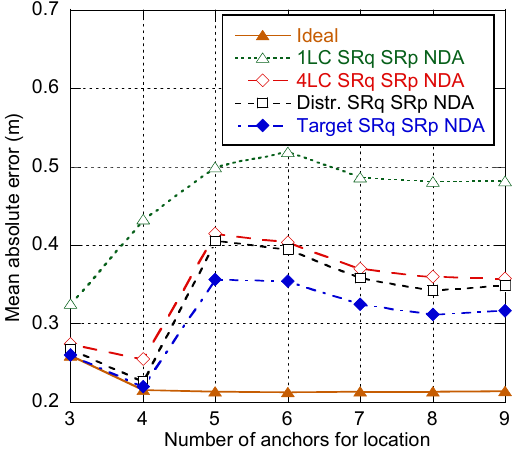
Figure 12. Positioning error for the tracking functional architectures (SRq SRp NDA).